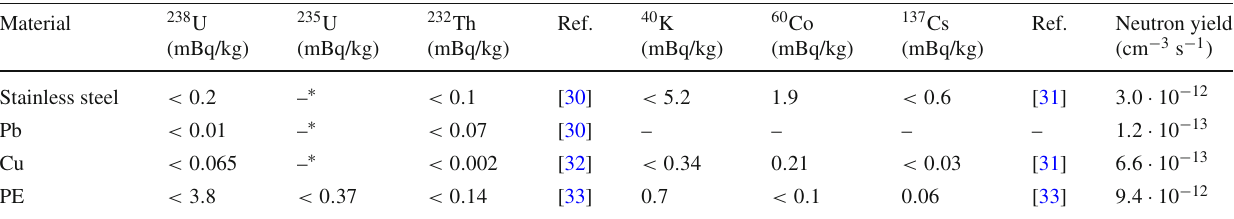
Table 2 Activity of the main contaminants in the materials considered for the COSINUS setup. Secular equilibrium is assumed for the decay chains. The rightmost column states the neutron yield due to (α, n ) and spontaneous fission reactions attained using the SOURCES4C code [25]